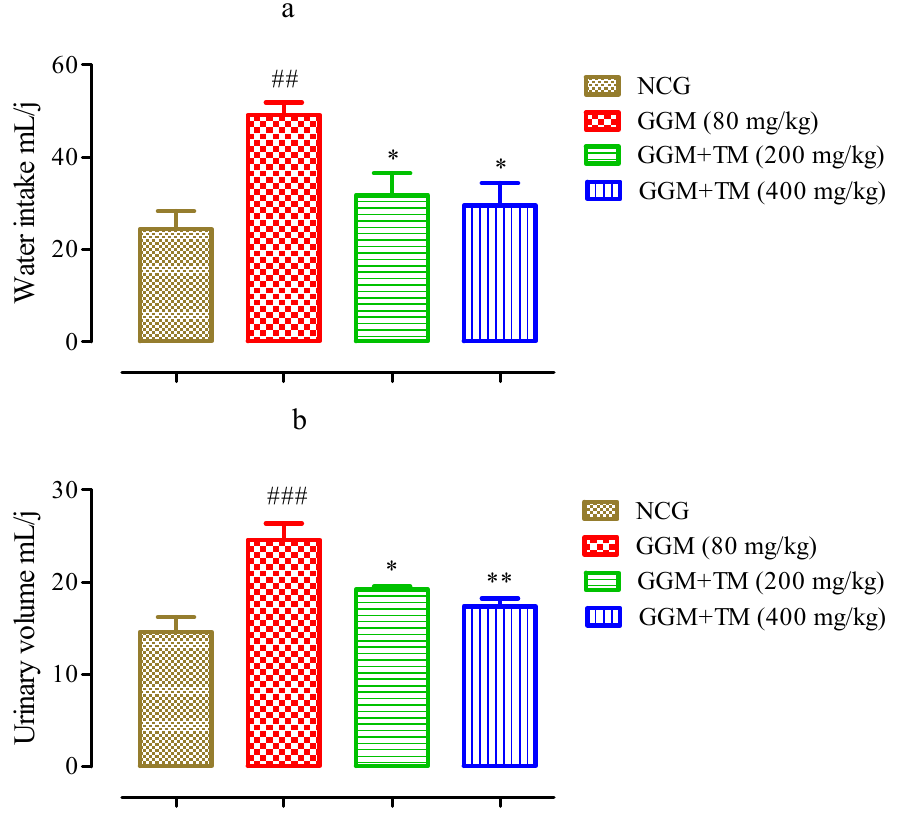
Figure 3. Effect of APTM on water supply ( a ) and urine output ( b ) in GM-poisoned rats. The data is provided as mean ± SEM, (n = 6). ### p < 0.001, ## p < 0.01, comparing to NCG. ** p < 0.01, * p < 0.05 related to GGM (80 mg/kg). Table 2. The impact of APTM aqueous extract on growth indices in GM-exposed rats.